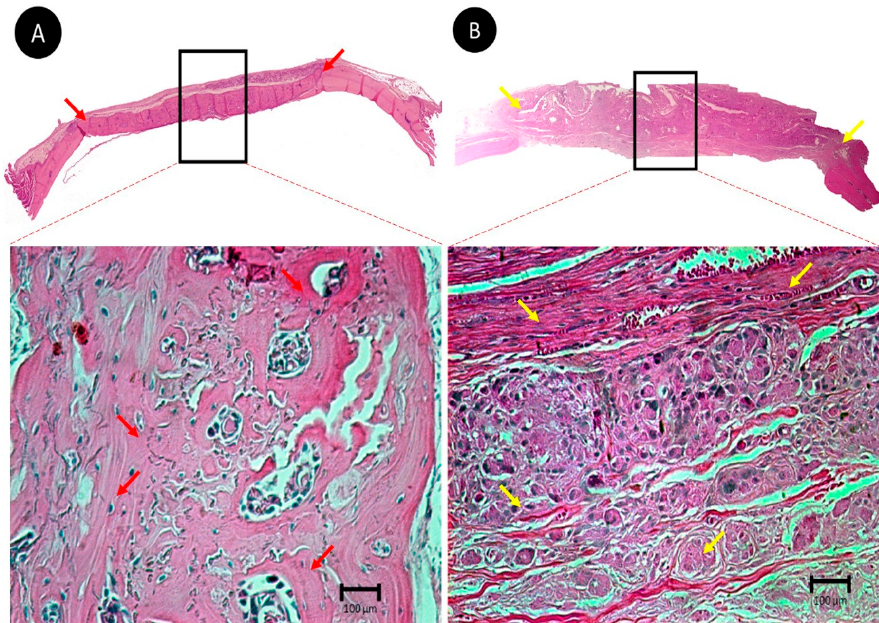
Figure 4. Photomicrographs of the smallest ( × 6.3) and largest ( × 25.0) histological sections of the delimited area (center of the defect) in the BG and BC experimental groups in the longest repair period (60 days). ( A ) The BG group; note the presence of bone neoformation from bone stumps and in the center of the defect (red arrows). ( B ) The BC group with a large amount of mature connective tissue and the presence of inflammatory infiltrate (yellow arrows).